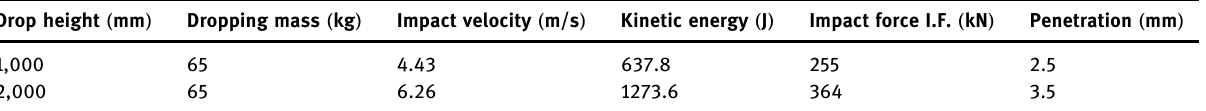
Table 4: Physical properties of each impact load Drop height ( mm )